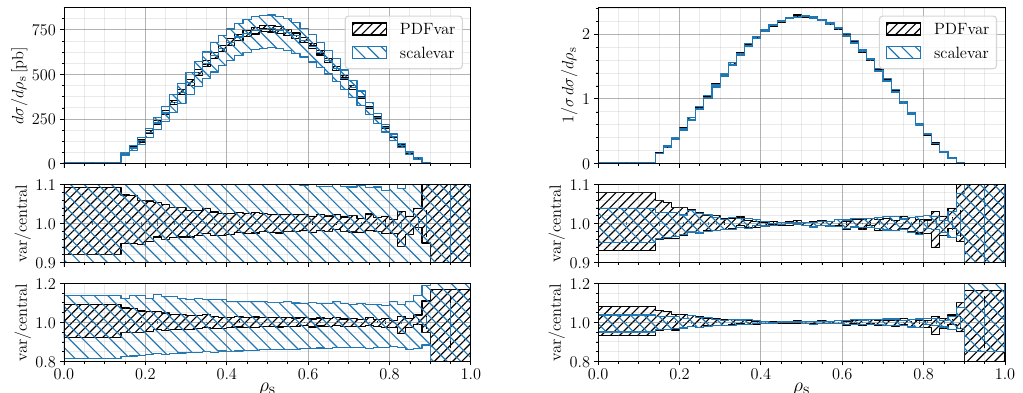
Figure 25 . Same as figure 24, but for predictions obtained with scale µ 0 = H B both the PDF uncertainty and the scale variation uncertainty were obtained using the NLO partonic cross